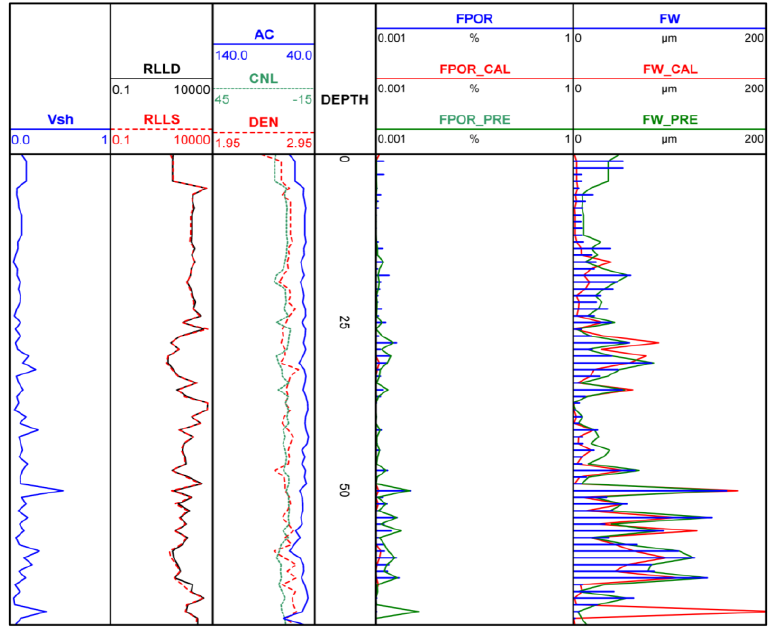
Figure 7. Comparison of the fracture width and fracture porosity calculated by dual laterolog and the proposed MLP method.